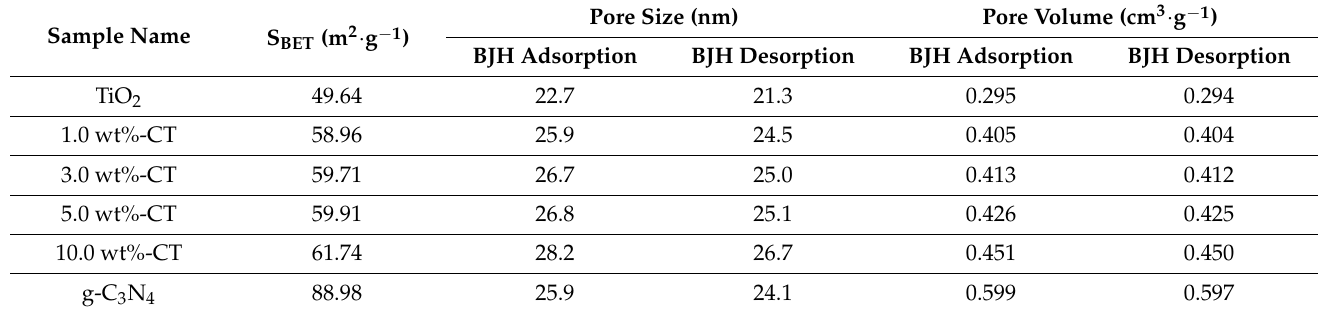
Table 1. BET specific surface area (S BET ), pore size, and pore volume of various g-C 3 N 4 /TiO 2 catalysts.